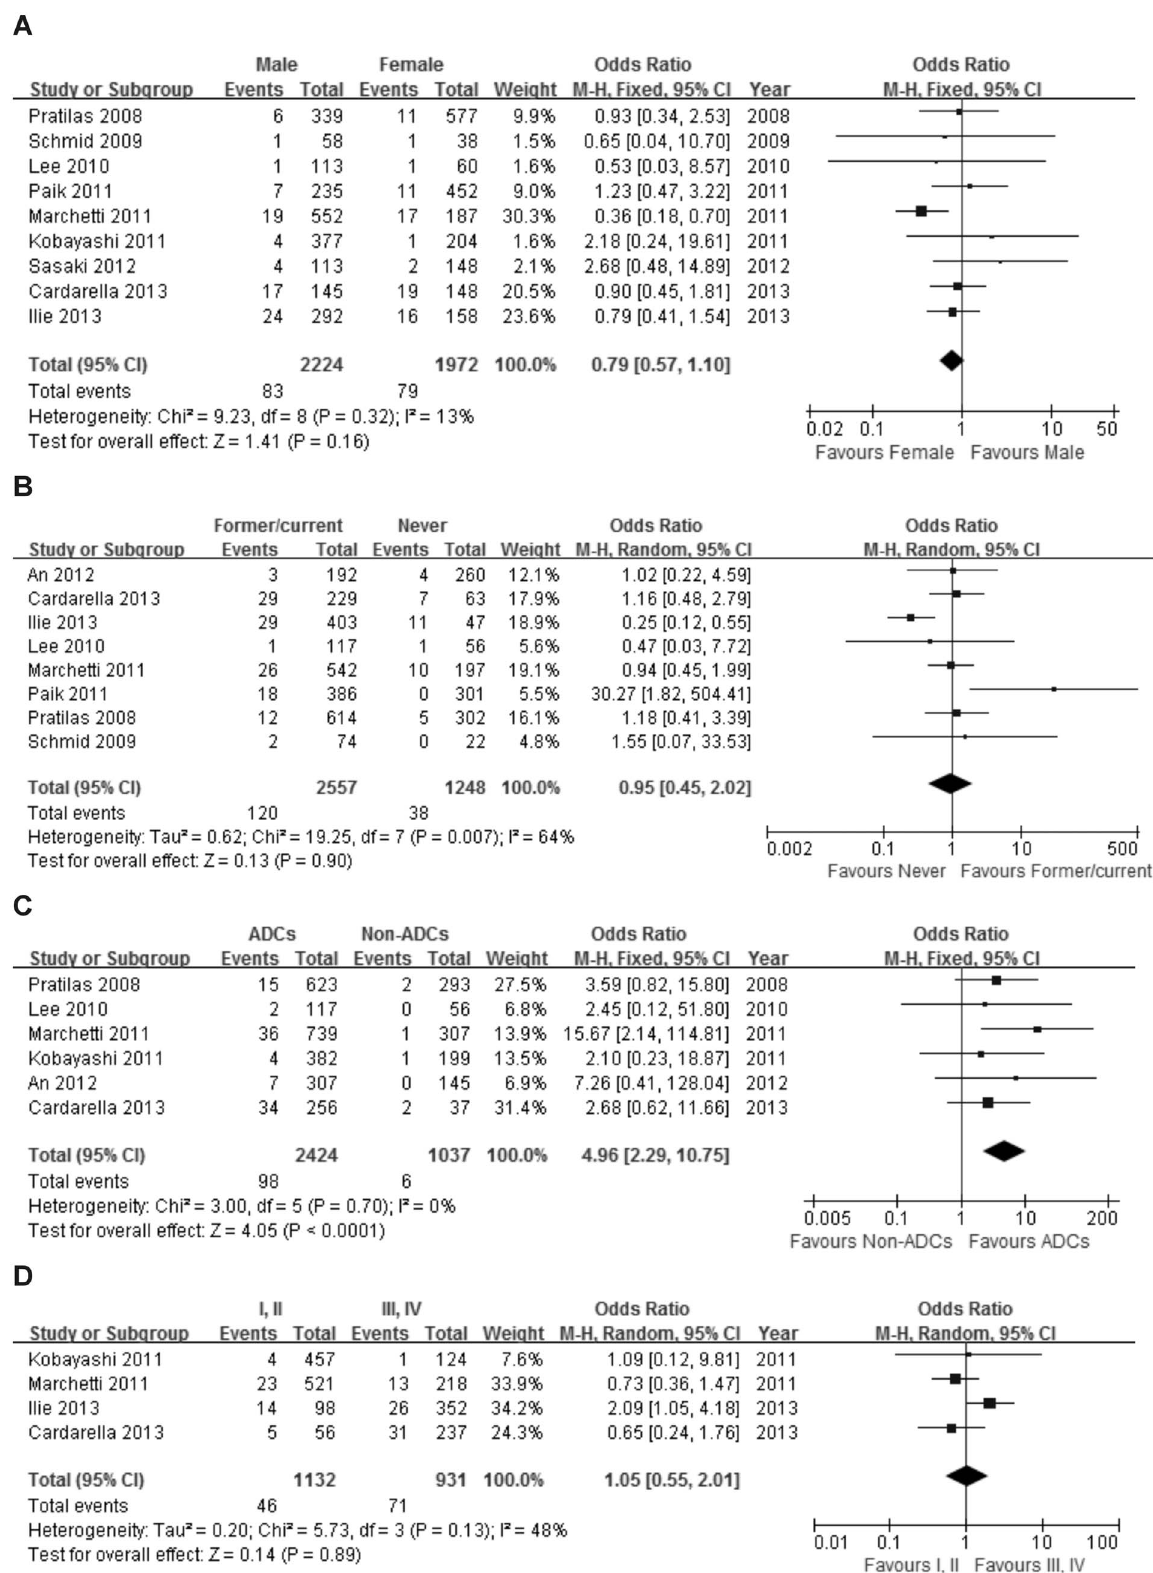
Figure 2. The association of BRAF mutations with gender (A), smoking (B), histology (C) and stage (D).